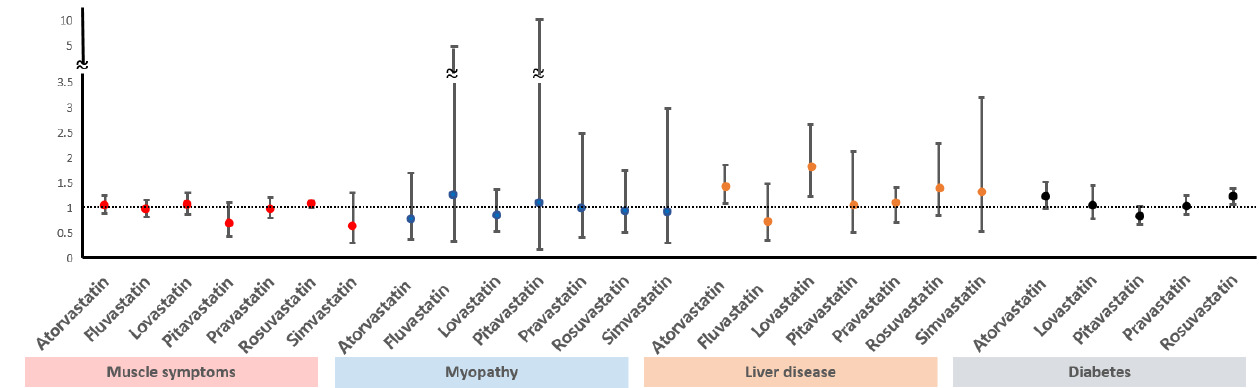
Figure 2. Comparison of side e ff ects among di ff erent statins. Horizontal bars indicate ORs with 95% CIs for the complications of statins. Vertical line indicates OR of 1 (no association). ORs, odds ratios; CIs, con fi dence intervals.